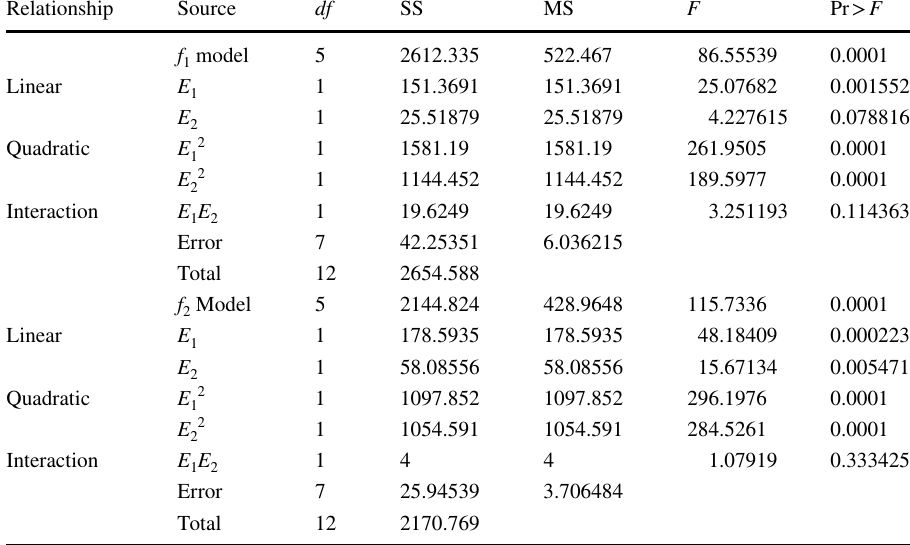
Table 3 ANOVA for the regression model and the respective models